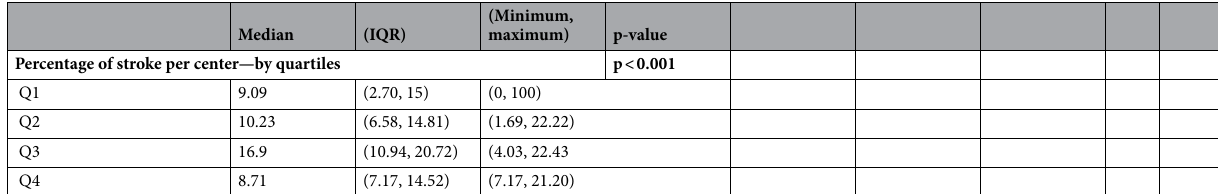
Table 1. Demographics of admissions cohort and analysis of SCD PICU mortality (N = 5264 admissions) * Significant values are in [bold]. * Totals include data from 138 centers representing 5264 ICU admissions from 3388 unique patients. If data was incomplete in the database, those reduced totals are noted. † For height, total N = 2747 due to missing data. ‡ VPS does not adhere to the standard definitions of race or ethnicity as defined by NIH, rather uses an internal definition. § Data analyzed with two-sample Wilcoxon